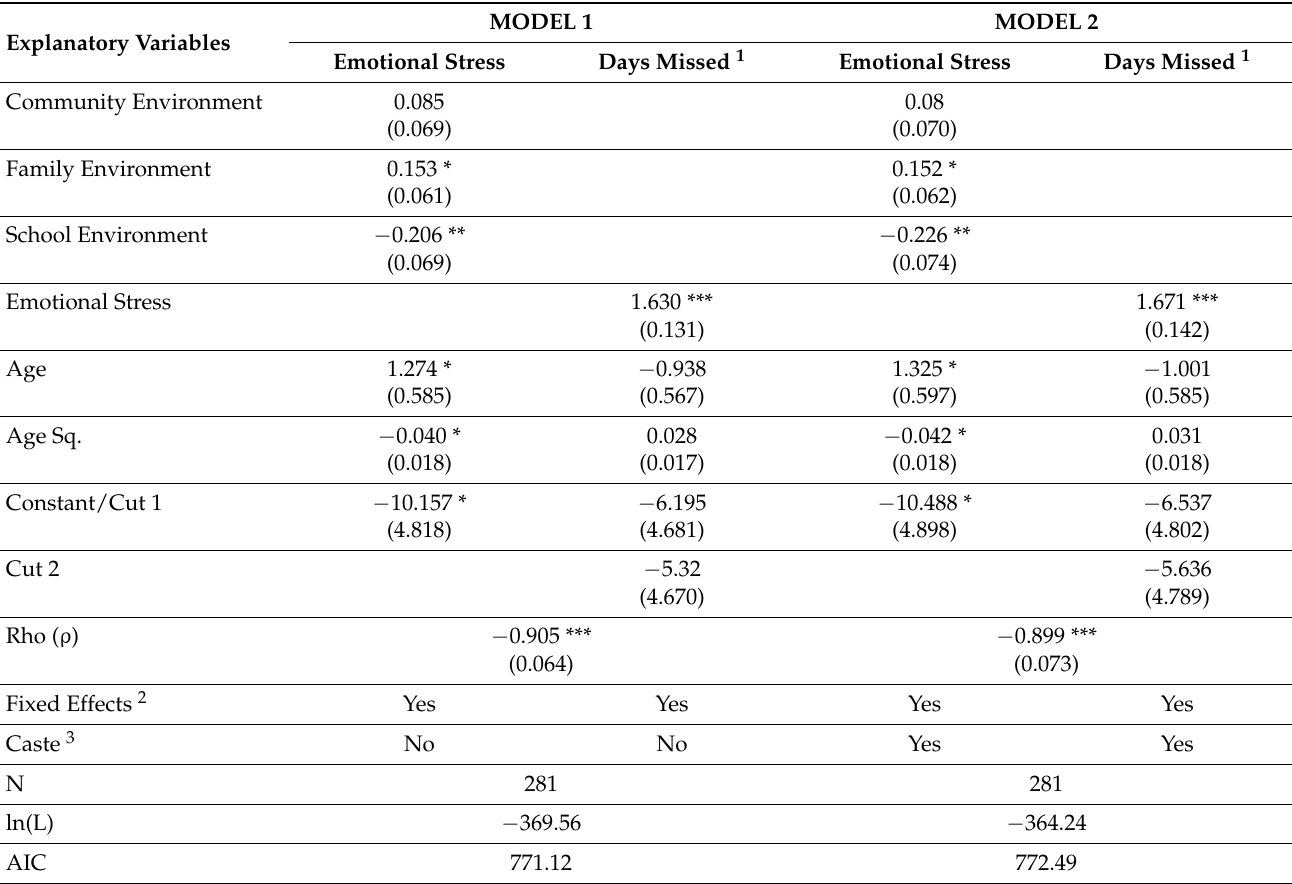
Table 5. Conditioned mixed process (CMP) estimation of menstruation-related emotional stress & school absence.